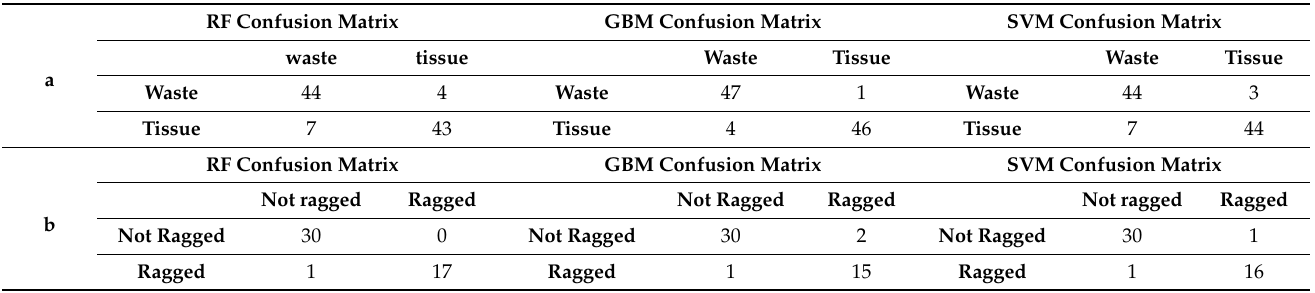
Table 2. Confusion matrix of the test set for each model: ( a ) waste-tissue classification results; ( b ) ragged–not-ragged classification